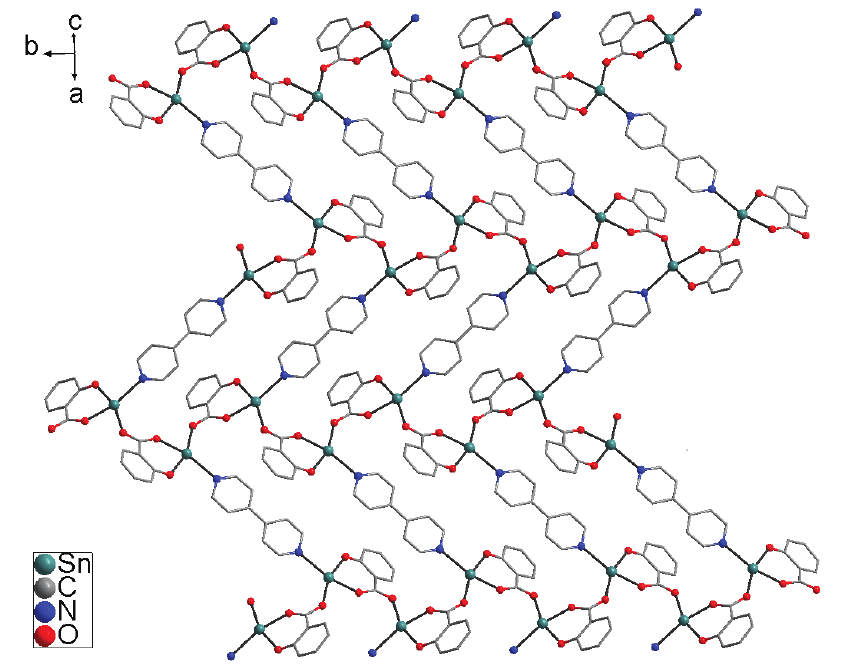
Figure 3: 2D herringbone structure of 1 containing 34-membered hexa-nuclear macrocyclic rings. The nitro and butyl groups are omitted for